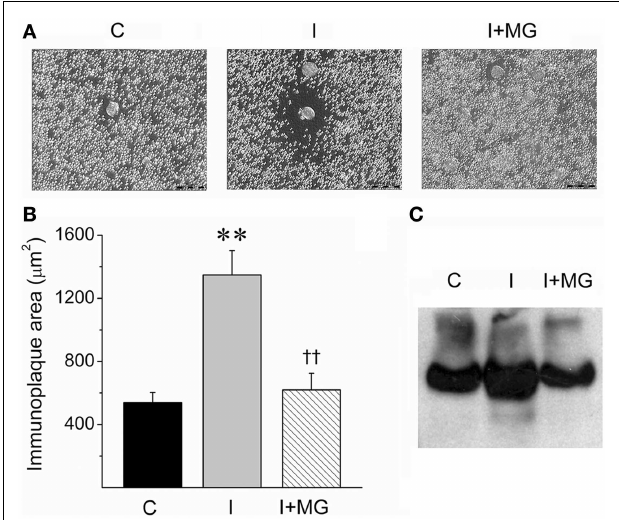
FIGURE 6 | Insulin-induced SIR cleavage by cultured hepatocytes is reduced by the protease inhibitor alpha2-macroglobulin (MG) . (A) Microphotographs of representative RHPA assays from control (C), 1nM insulin-treated hepatocytes, (I), and 1nmoll − 1 insulin-stimulated plus 1.5mg/ml alpha2-macroglobulin (I + MG). Scale bars: 50 µ m. (B) Immunoplaque areas (IPA) as a measure of SIR releasing activity. IPA was calculated after 24h of incubation in three experiments in duplicate except for MG ( n = 2 in duplicate). Bars represent mean ± SEM, ** p < 0.01 for comparison against control and †† p < 0.01 for comparison against 1nmoll − 1 insulin condition. (C) Western blot for SIR of supernatants of hepatocytes cultured in the same conditions of RHPA for 5days.